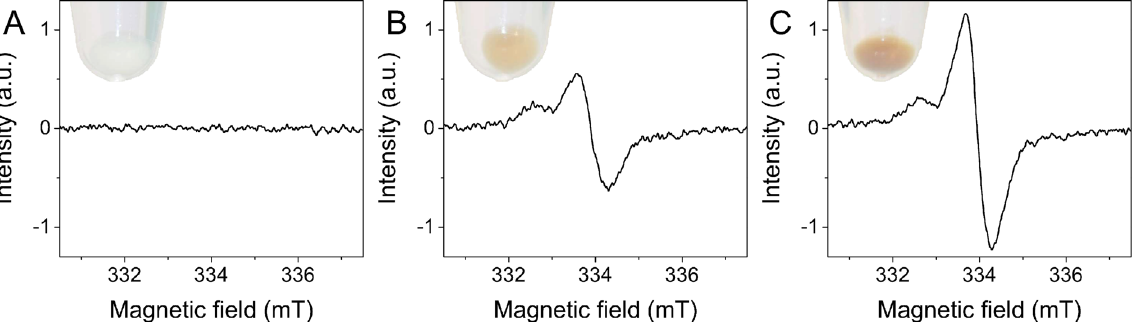
Figure 1. Determination of melanin in cell samples used in the experiments. EPR spectra of non-pigmented melanoma cells ( A ) and of pigmented melanoma cells with different levels of melanin pigmentation: moderately-pigmented ( B ) and heavily-pigmented ( C ) cells. The melanin EPR signal of pigmented cells is a superposition of pheomelanin signal (low field component) and eumelanin signal (high field component). Insets show images of cell pallets taken before freezing for EPR analysis. Note that the pellet of non-pigmented cells is white i.e. the cells are amelanotic, whereas the pellets of pigmented cells have a yellow-reddish color, which is typical for samples containing a mixture of pheomelanin and